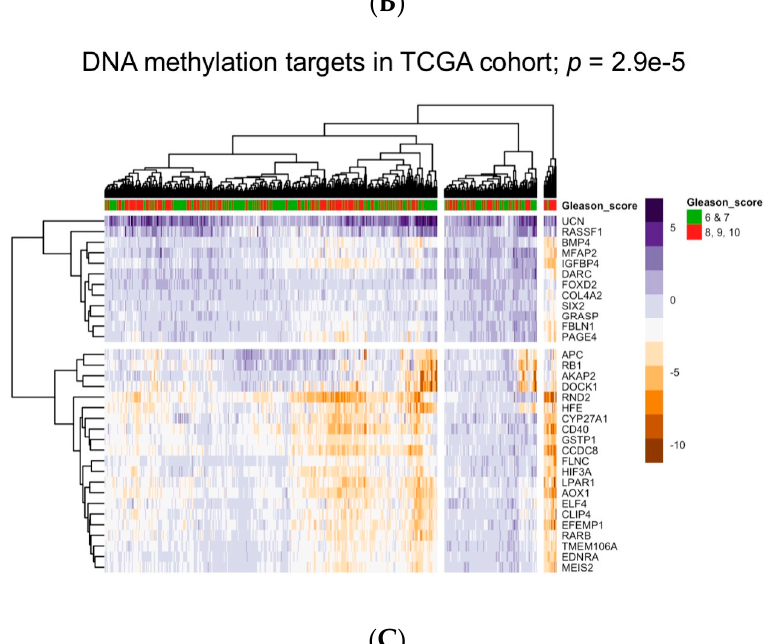
Figure 1. Expression and association of the DNA methylation pathway genes with tumor outcome. ( A ) Heatmap illustrating common and significantly altered mRNA expression of the DNA methylation pathway in the Cancer Genome Atlas (TCGA) prostate cancer (PRAD) cohort ( n = 497). Gene expression was measured as normal tissue relative Z ‐ scores of all genes detectable in at least 80% of tumors. Cluster membership significantly identifies aggressive tumors ( p < 0.006). ( B ) The negative and positive correlation (Pearson correlation either < − 0.6 or >0.6) for each of these commonly altered genes from the DNA methylation pathway ( n = 21) and all other detectable genes in the TCGA cohort ( n = 16,785) was measured and the enrichment of the 165 common targets of DNA methylation from the Lynch et al. review [132] was measured using a hypergeometric test. Only the indicated genes had significant correlation with all genes and significant enrichment of the targets of DNA methylation. ( C ) Heatmap illustrating common and significantly altered mRNA expression of genes that significantly correlate with Indolethylamine N ‐ Methyltransferase (INMT) and Methionine Adenosyltransferase 2B (MAT2B) and are known targets of DNA methylation in TCGA PRAD cohort. Cluster membership significantly identifies aggressive tumors ( p < 0.0007).